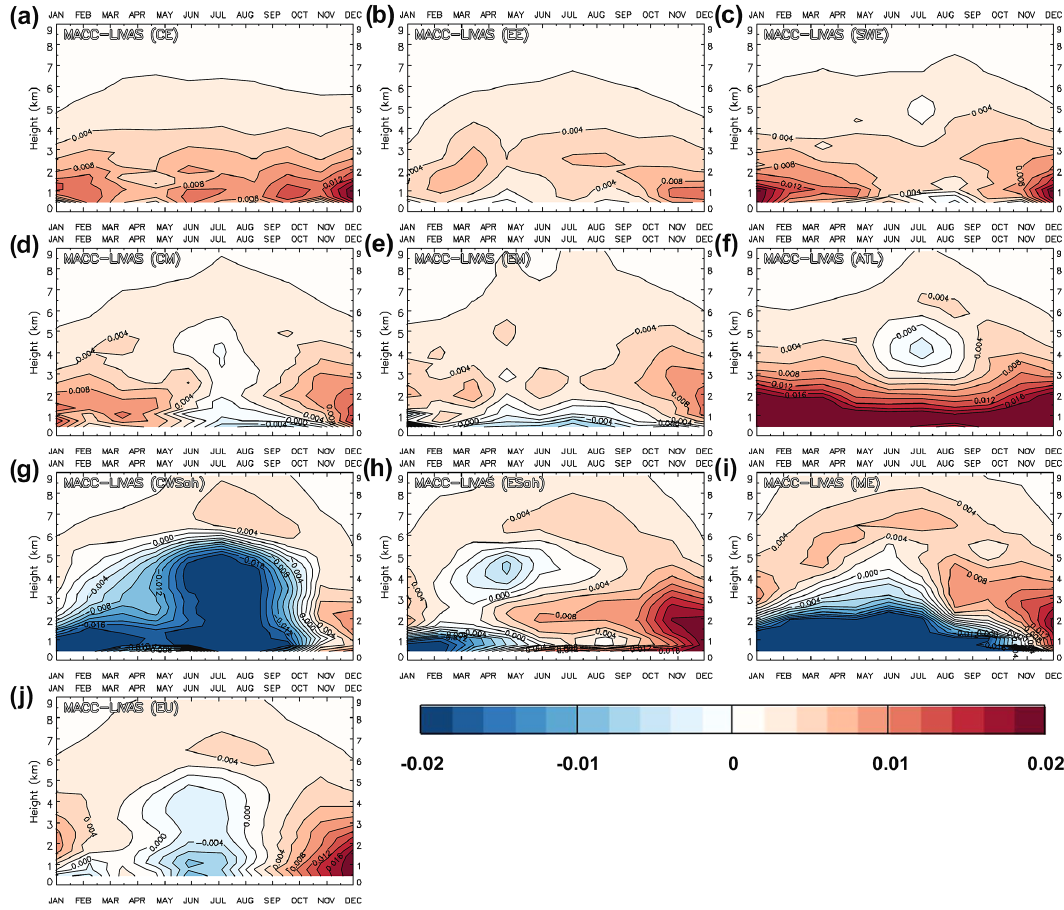
Figure 8. Monthly variability of the MACC–LIVAS dust extinction coefficient mean bias profiles (in km − 1 ) over the nine subregions of interest (a–i) and over the whole Europe–northern Africa–Middle East domain (j) .